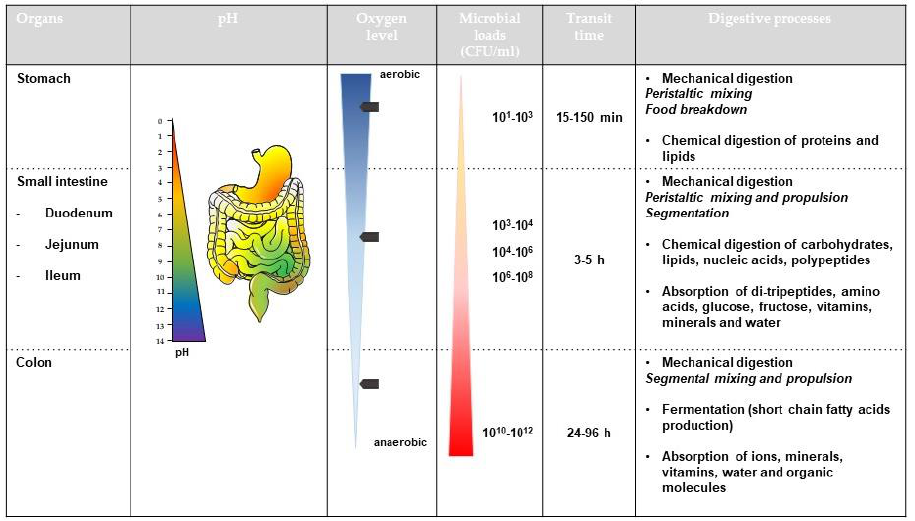
Figure 1. Overview of the main physical and chemical processes of the human gastro-intestinal tract.